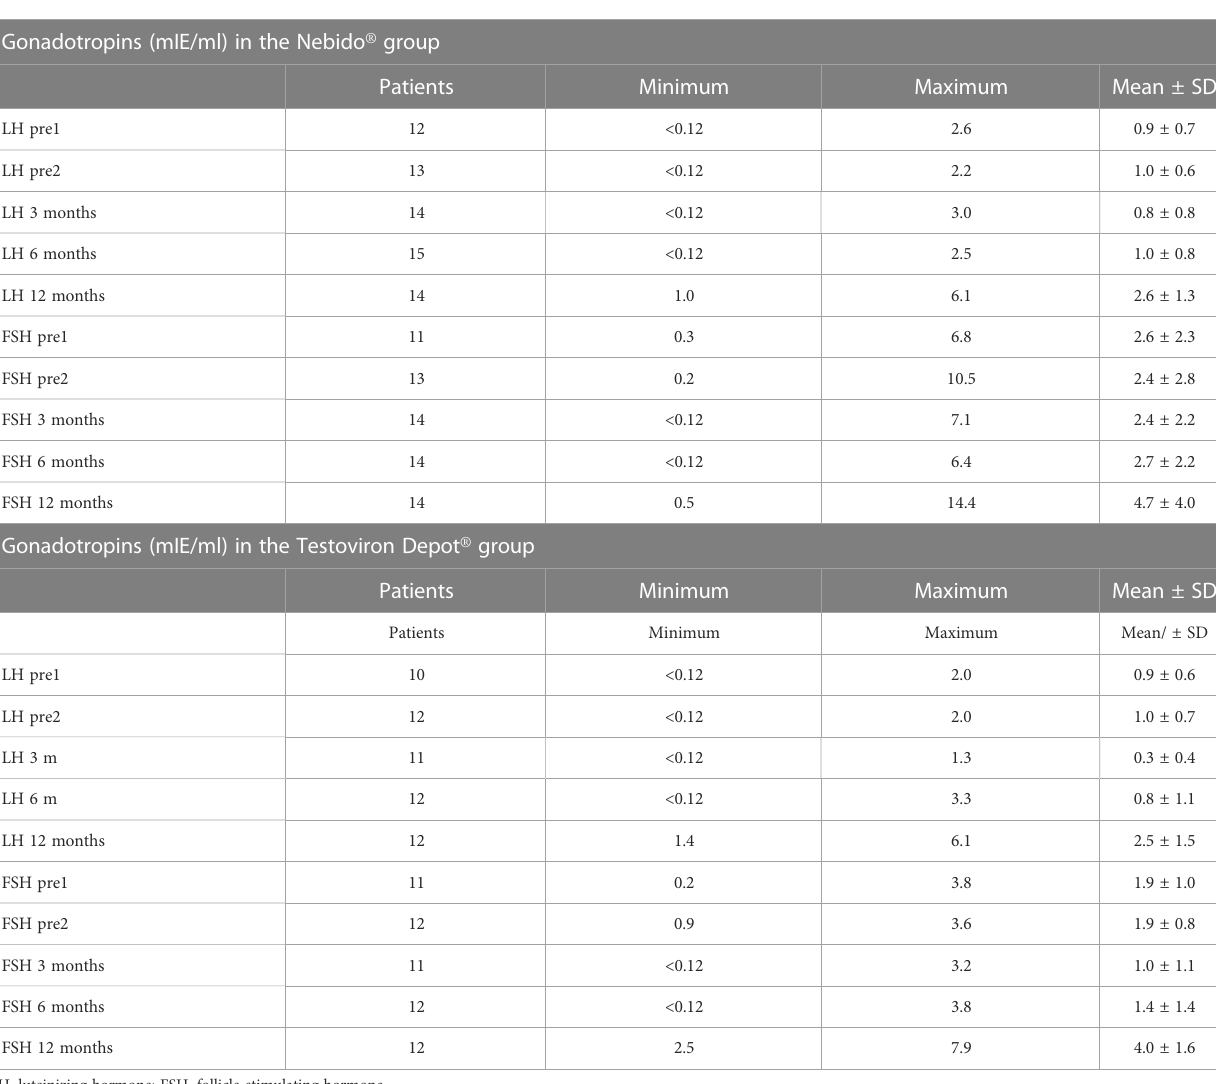
TABLE 4 Gonadotropin levels in patients in the Pubertal Replacement in Boys